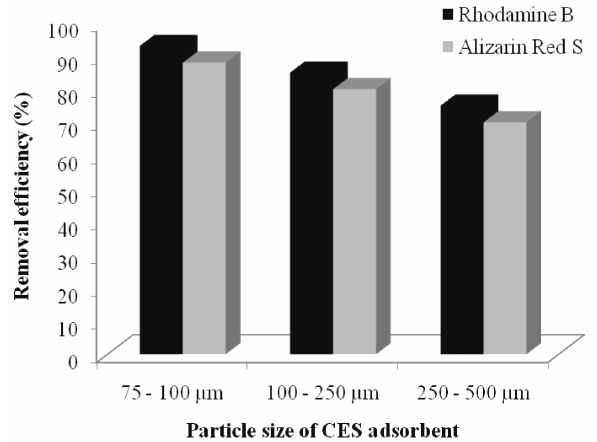
Fig. 9 – Effect of CES adsorbent particle size on dye removal efficiency